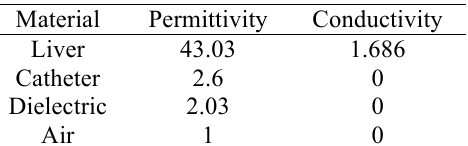
Table 2: Materials properties